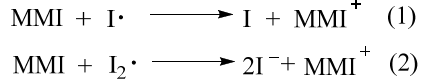
Scheme 1. Reaction of MMI with iodine free radical.